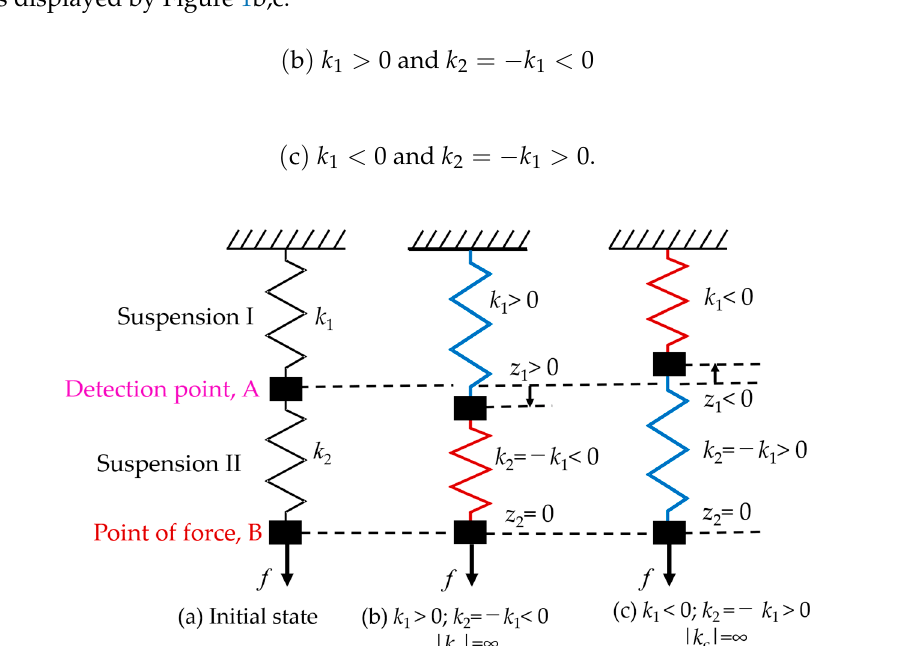
Figure 1. Zero-compliance by using series suspension [23]. ( a ) Initial state of the suspension; ( b ) Positive stiffness is set for Suspension I and negative stiffness is set for Suspension II; ( c ) Negative stiffness is set for Suspension I and positive stiffness is set for Suspension II.